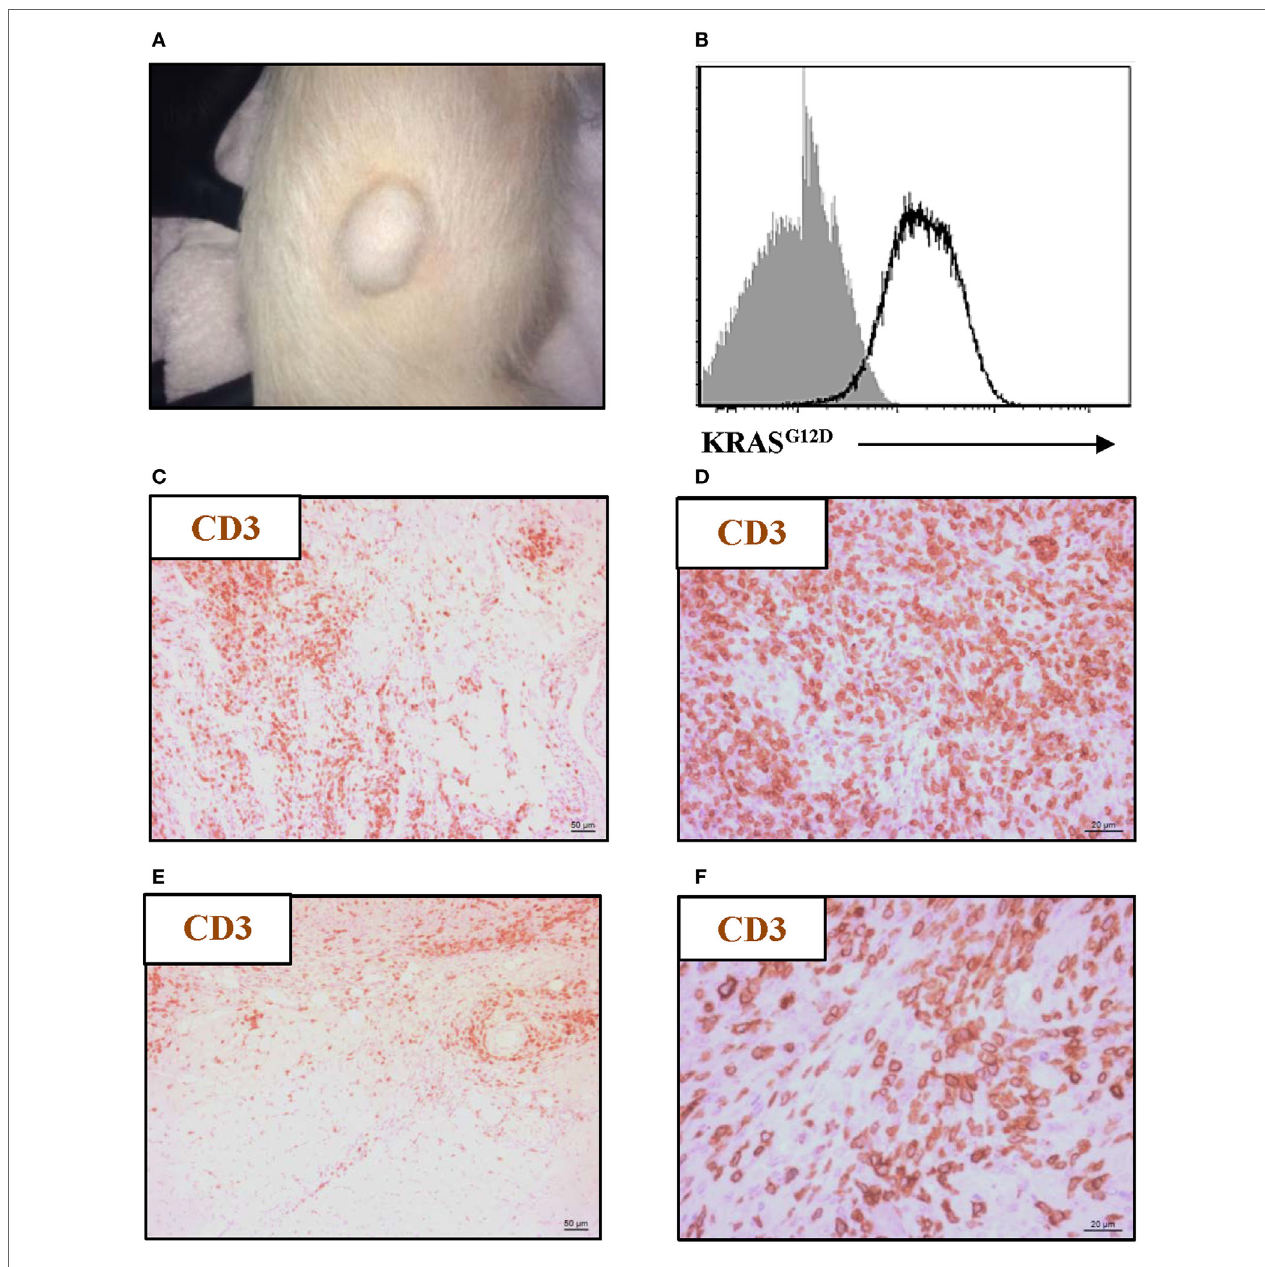
FigUre 1 | Oncopig tumors are infiltrated by T cells. The KRAS G12D and TP53 R167H floxed Oncopigs were subcutaneously injected with AdCre to induce tumorigenesis. (a) Representative image of subcutaneous tumor formation in Oncopigs 7–21 days post subcutaneous injection into the flank of AdCre ( n = 6), where n indicates the number of animals. (B) Representative intracellular flow cytometric plot of KRAS G12D - expression in isolated tumor cells (white) with fluorescence-minus-one control indicated (gray). Oncopigs were subcutaneously into the flank (c,D) or intramuscularly into the leg (e,F) injected with AdCre, and tumor sections were harvested 20 days post injection. Representative immunohistochemistry images with detection of CD3 + cells at 10 × (c,e) and 40 × (D,F) magnifications are shown ( n = 3), where n indicates the number of